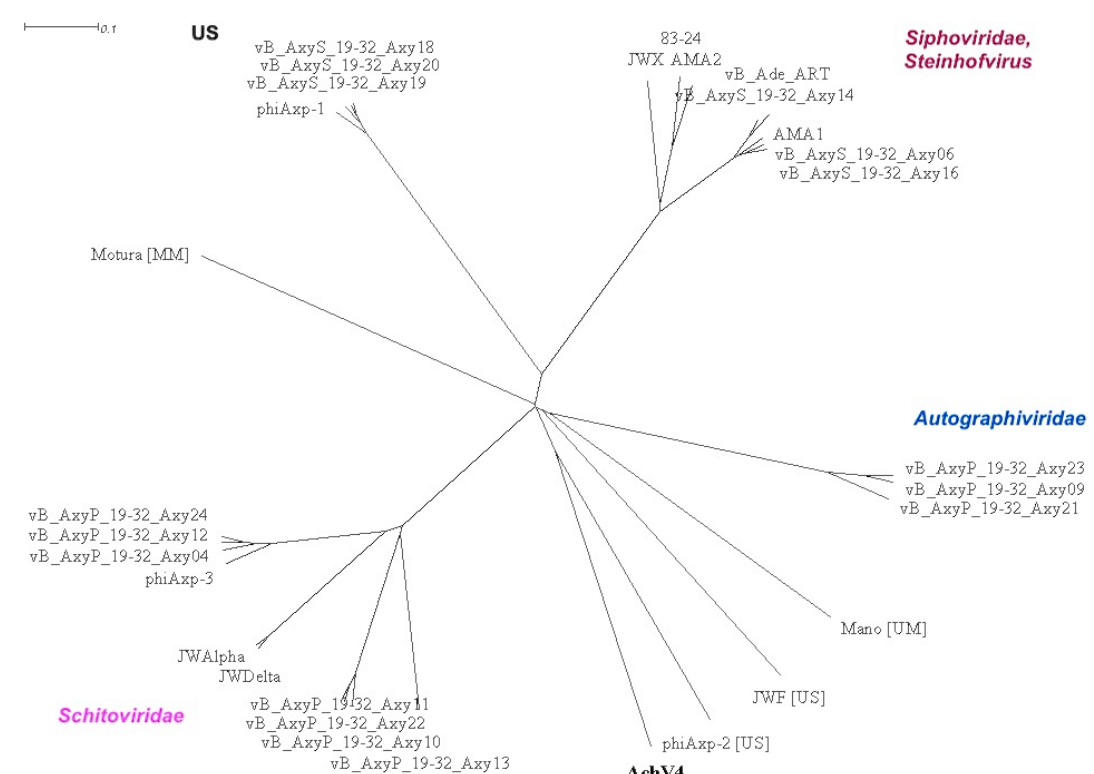
Figure 7. Splitstree representation of the unrooted proteomic tree generated by ViPTree web-service based on the genome-wide similarity relationships between Achromobacter bacteriophages. Purple, phages of the family Schitoviridae ; red, siphoviruses that belong to the genus Steinhofvirus; blue, phages from the family Autographiviridae. UM—unclassified myovirus; MM—family Myoviridae , genus Mieseafarmvirus; US—unclassified siphoviruses.